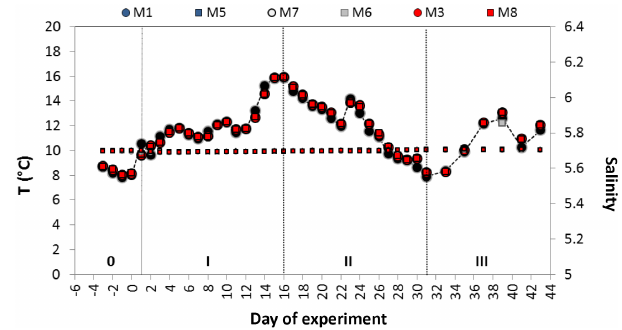
Figure 3. Temperature and salinity averaged over the 17m surface layer of the mesocosms and the fjord. The data were obtained from daily CTD casts. Large symbols represent temperature and the small symbols salinity. Fjord water is shown as black dots with broken line while blue symbols denote untreated, grey intermediate and red high f CO 2 levels in the mesocosms. According to the tempera- ture regime, the experimental period can be divided into four phases (phases 0, I, II and III).